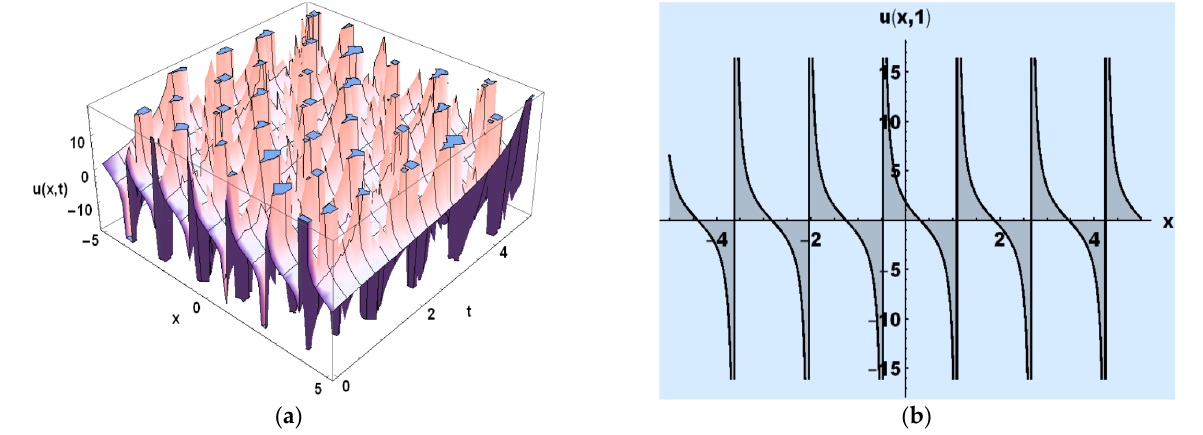
Figure 5. ( a , b ): Graphical analysis of Equation (22) for the values of the parameters A = 2, B = 2, E = 1, F = 1, H = 1, ψ = 1, δ = 1, L = 1, α = 0.75, − 5 ≤ x ≤ 5, 0 ≤ t ≤ 5 for